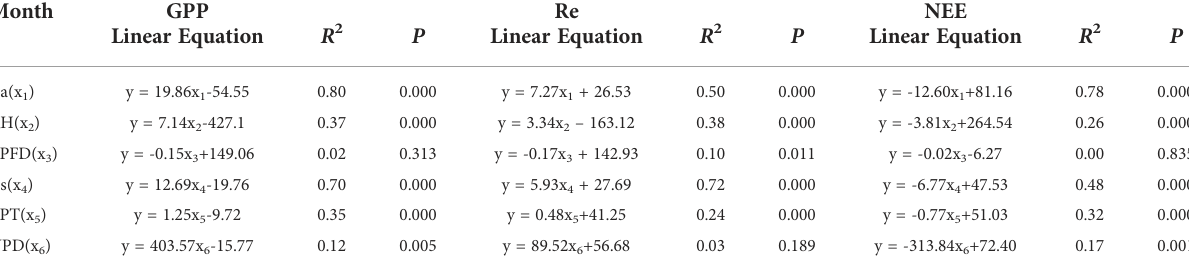
TABLE 1 Linear regressions between monthly CO 2 fl uxes and environmental variables of alpine wetland in the growing season (May-September). Month GPP Re NEE Linear Equation Linear